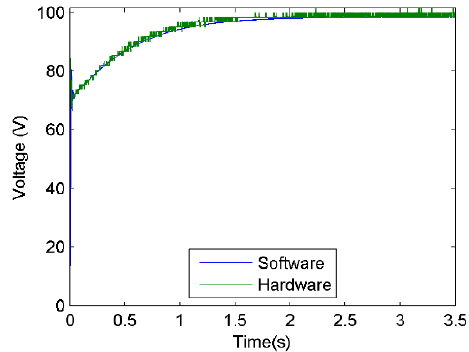
Figure 29. PVPE voltage response with PI CSE.